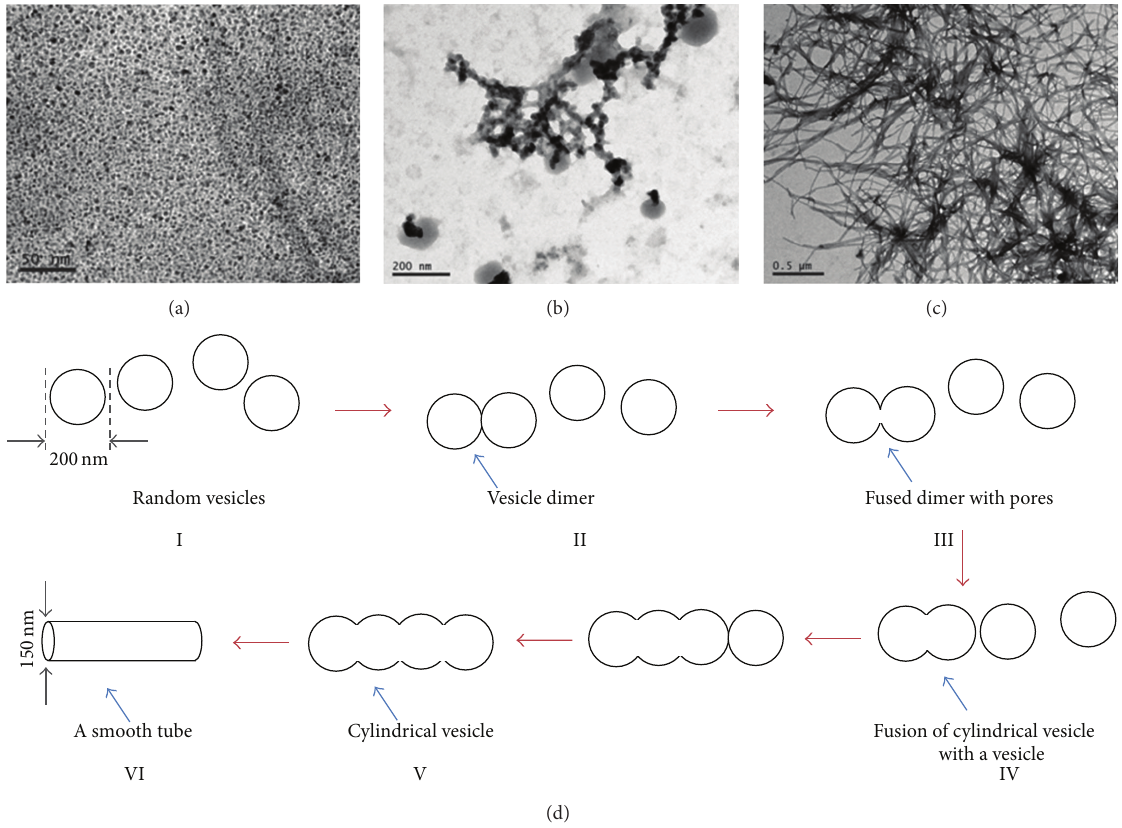
Figure 5: TEM micrographs of nanostructures obtained from compound 1 in DMF/water mixture: (a) distribution of nanovesicles; (b) pearl- chain like fused nanovesicles; (c) nanotubes; (d) proposed mechanism of nanotube formation by vesicle fusion.